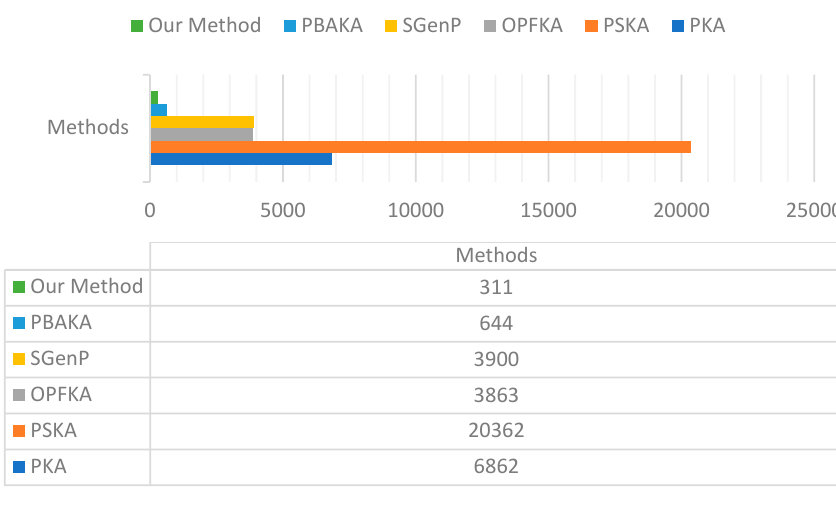
Figure 11. Memory overhead in bytes for the proposed method and other methods.